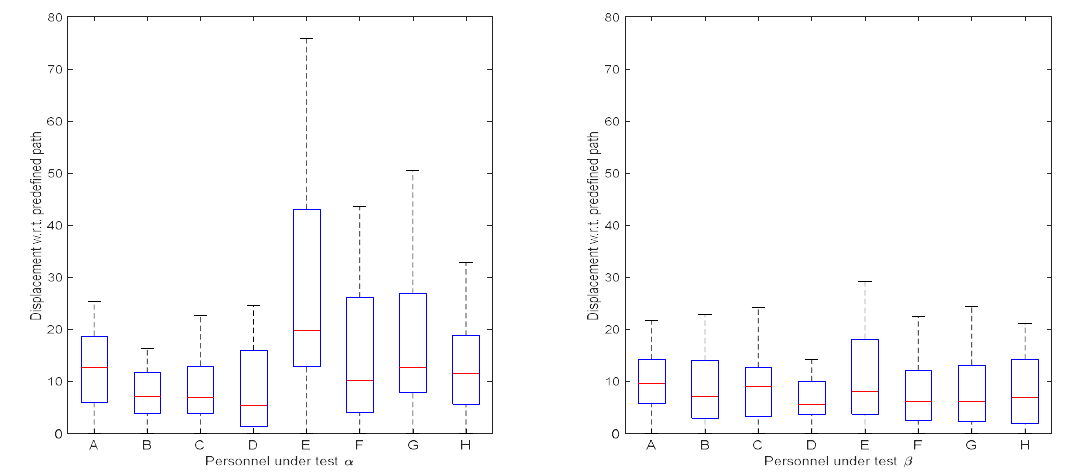
Figure 12. Displacement to predefined path in virtual field tests.